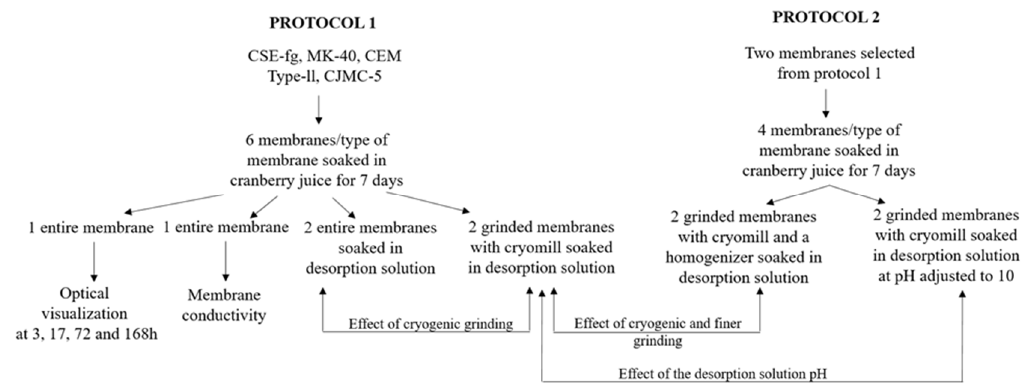
Figure 1. Design of the two desorption protocols.